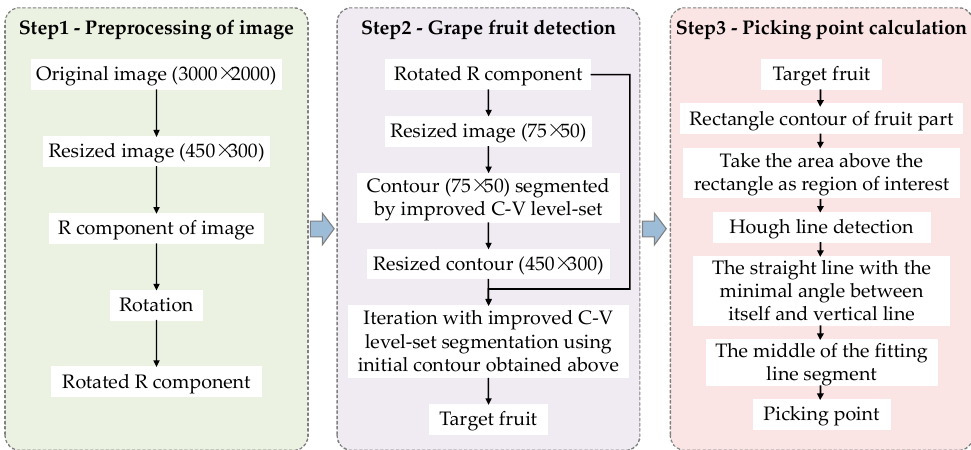
Figure 4. Algorithm flow diagram of the proposed method.